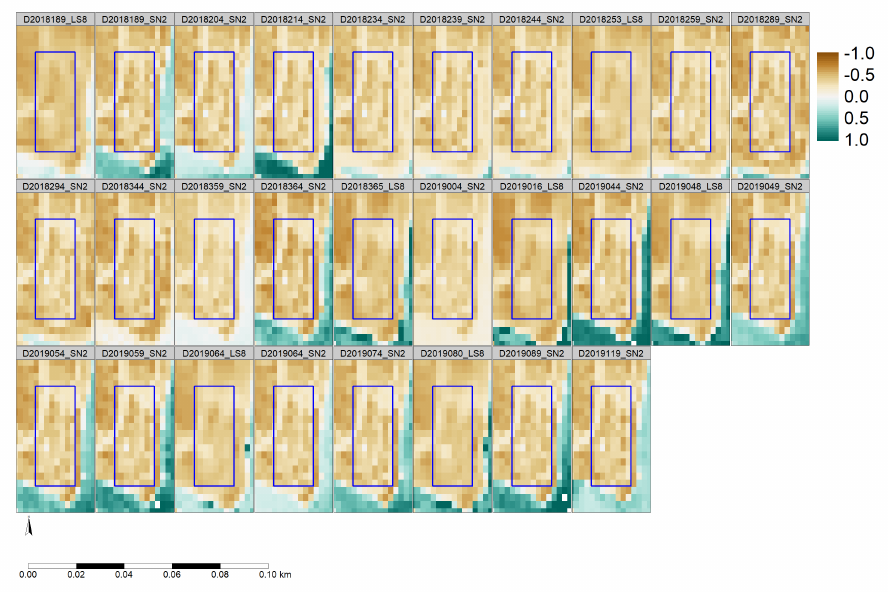
Figure A2. Classification of the NDWI series after thresholding. Figure labels show the capturing date of the satellite image using the year and Julian day ( YYYYJJJ ) format and an abbreviation of the satellite program ( LS8 and SN2 stand for Landsat-8 and Sentinel-2.)